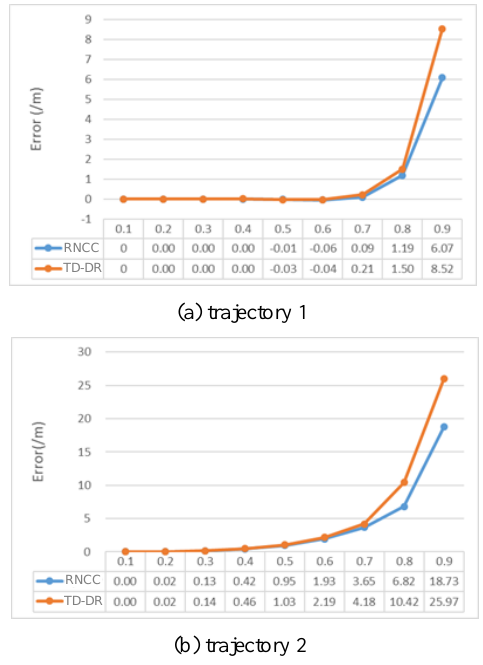
Figure 7. Accuracy